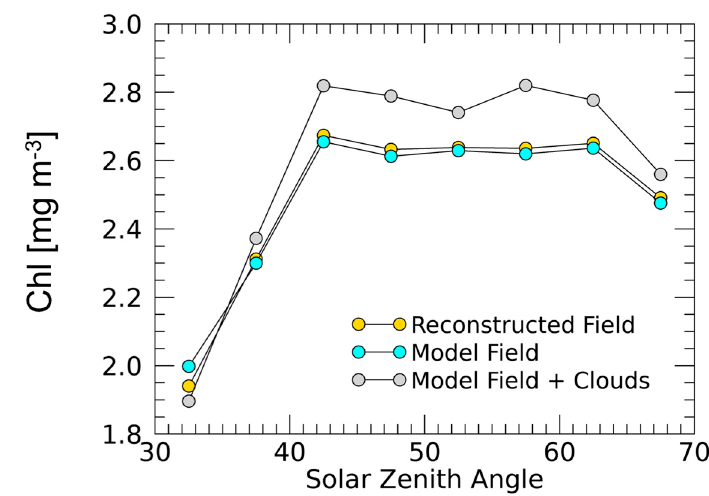
Figure 6. Chl variability as a function of the solar zenith angle (in degrees) using mean Chl GEO retrievals after reconstruction with M-SSA (in yellow) in comparison to the original modeled Chl fields (in cyan) and the model Chl with clouds over-imposed (in grey).